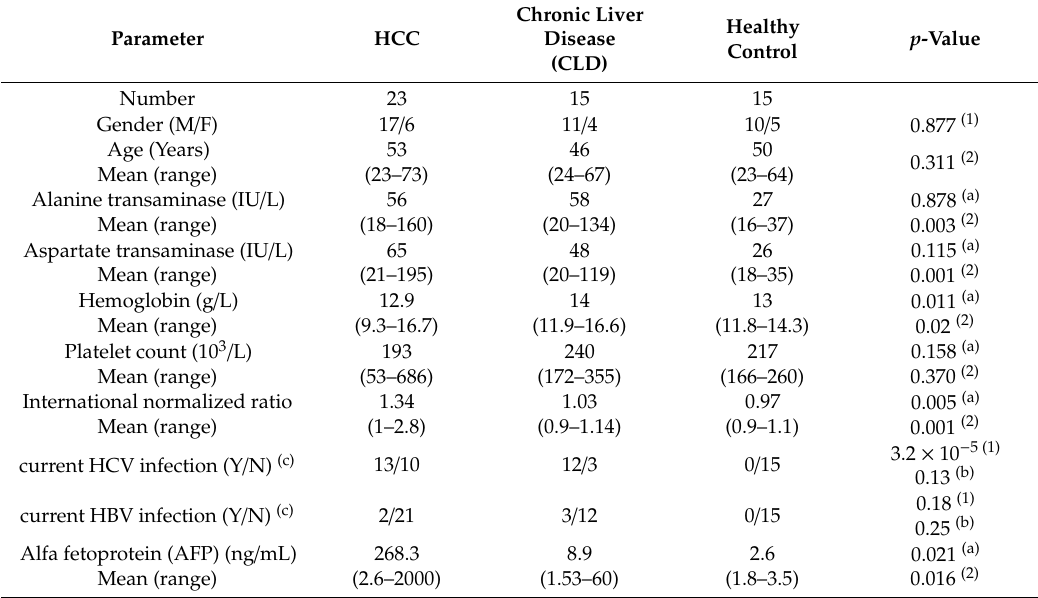
Table 1. Clinical and biochemical characteristics of study subjects.